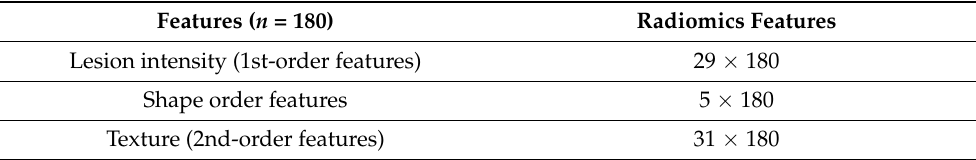
Table 1. Composition of 11,700 radiomic features extracted using LIFEx